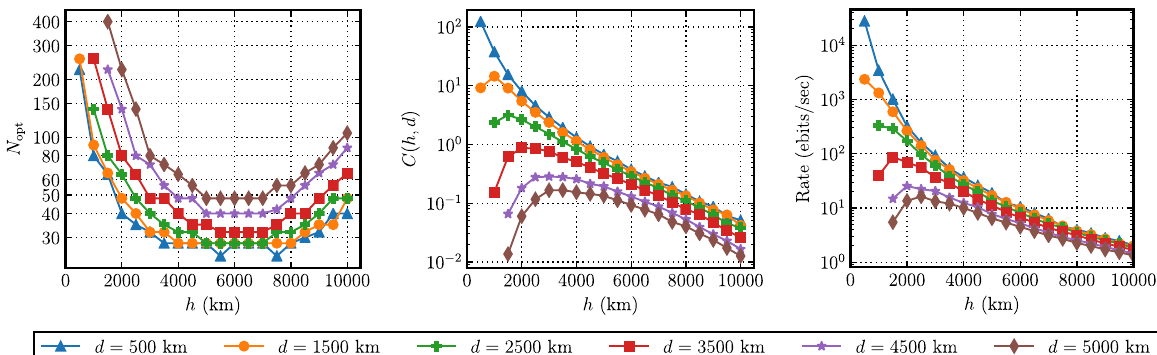
Fig. 3 Simulation results for two ground stations at the equator separated by a distance d . Left — optimal number N opt ( h , d ) of satellites for continuous 24-h coverage. Center — Figure of merit in eq. (4) in units of ebits/s per satellite. Satellite con fi gurations corresponding to the maxima of the curves are shown in Table 1. Right — entanglement-distribution rates corresponding to the points in the plot in the central panel. We assume a source rate of R source = 10 9 ebits/s 100 .